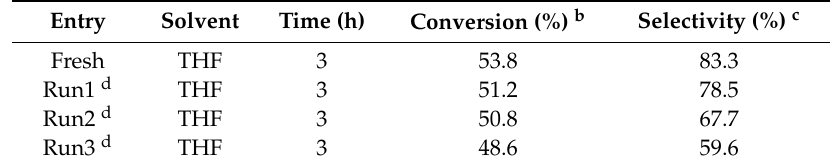
Table 2. Recyclability of Ca(II) coordination polymer catalyst in the oxidation of benzyl alcohol at 130 ◦ C a